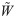
The biologically plausible weights matrix W.(A) The synaptic weight matrix is sparse and Daleian (neurons with id ≥ 4000 only make inhibitory connections). Only 100 excitatory and 25 inhibitory neurons are shown (B) Singular value decomposition of weight matrix W. W has more than four non-zero singular values, i.e. rank >D. (C) The sum of incoming excitatory weights to each neuron (one point) is similar to the sum of incoming inhibitory weights, indicating E/I balance. (D) Distribution of synaptic weights. The distribution is heavy-tailed but not perfectly log-normal. (E) Correlation between W and W˜ (inside manifold perturbation of K) and between W and W^ (outside manifold perturbation). For comparison a third option with a completely independent K is also shown. Error bars indicate standard deviation over 23 different permutations.